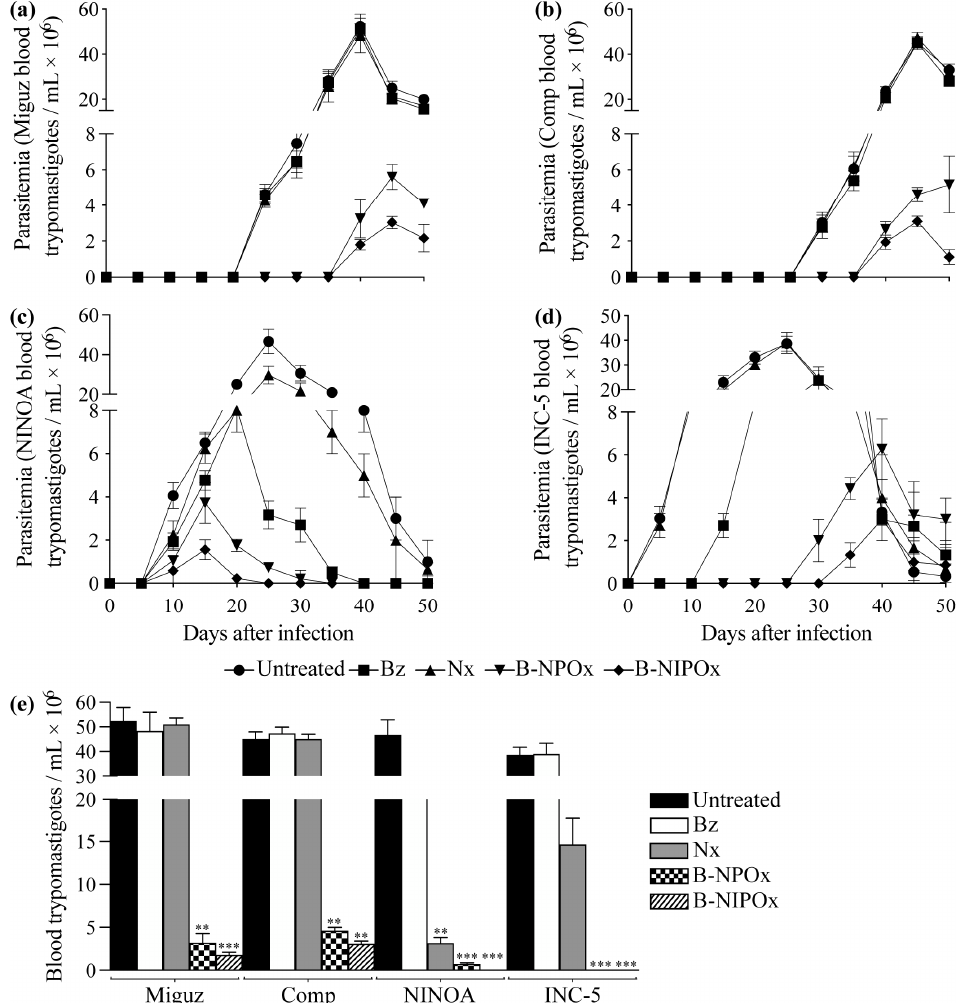
Figure 5. The benzyl ester of N-isopropyl oxamic acid (B-NIPOx) is more effective to reduce the blood parasitemia of mice infected with Trypanosoma cruzi than the benzyl ester of N-propyl oxamic acid (B-NPOx) and the reference drugs Benznidazole and Nifurtimox. Parasitemia was evaluated in the blood of mice infected with the ( a ) Miguz, ( b ) Compostela (Comp), ( c ) NINOA or ( d ) INC-5 T. cruzi strains. The infected mice were treated with Benznidazole (Bz), Nifurtimox (Nx), B-NPOx or B-NIPOx with daily dosing at 100 mg/Kg for 50 days. Blood samples were collected every 5 days from the tail vein, and the parasitemia was determined with the Filardi and Brener method; the controls were infected and untreated mice. ( e ) Asterisks represent statistically significant differences between the blood parasitemia of mice infected with the T. cruzi strains and treated with Bz, Nx, B-NPOx or B-NIPOx, compared to the infected and untreated mice, at the time the untreated mice reach the parasitemia peak (** p ≤ 0.01 and *** p ≤ 0.001) n = 6. One experiment representative of three is shown.